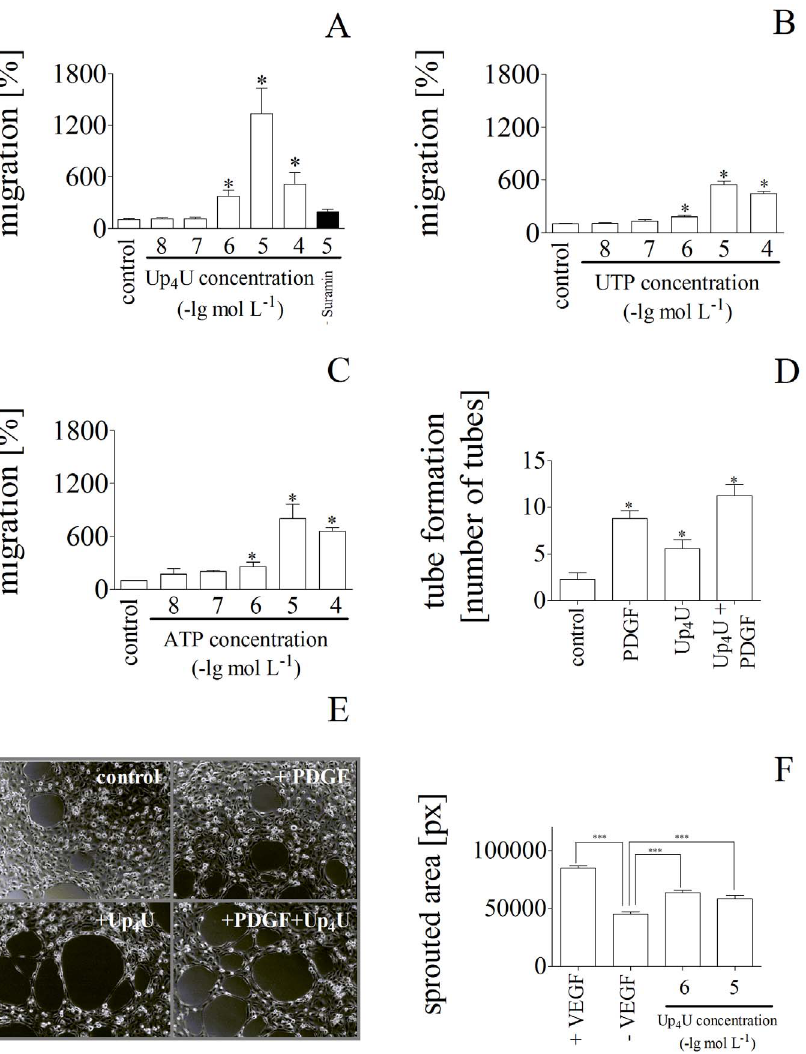
Figure 3. ( A )Effect of increasing Up 4 U concentrations on migration rate of endothelial cells in the absence (open bar) and presence (filled bar) of suramin (n=6). ( B )Effect of increasing UTP concentrations on migration rate of endothelial cells (n=3). ( C )Effect of increasing ATP concentrations on migration rate of endothelial cells (n=3). ( D ) Effect of increasing Up 4 U concentrations on tube-formation rate of endothelial cells (5 10 2 5 mol L -1